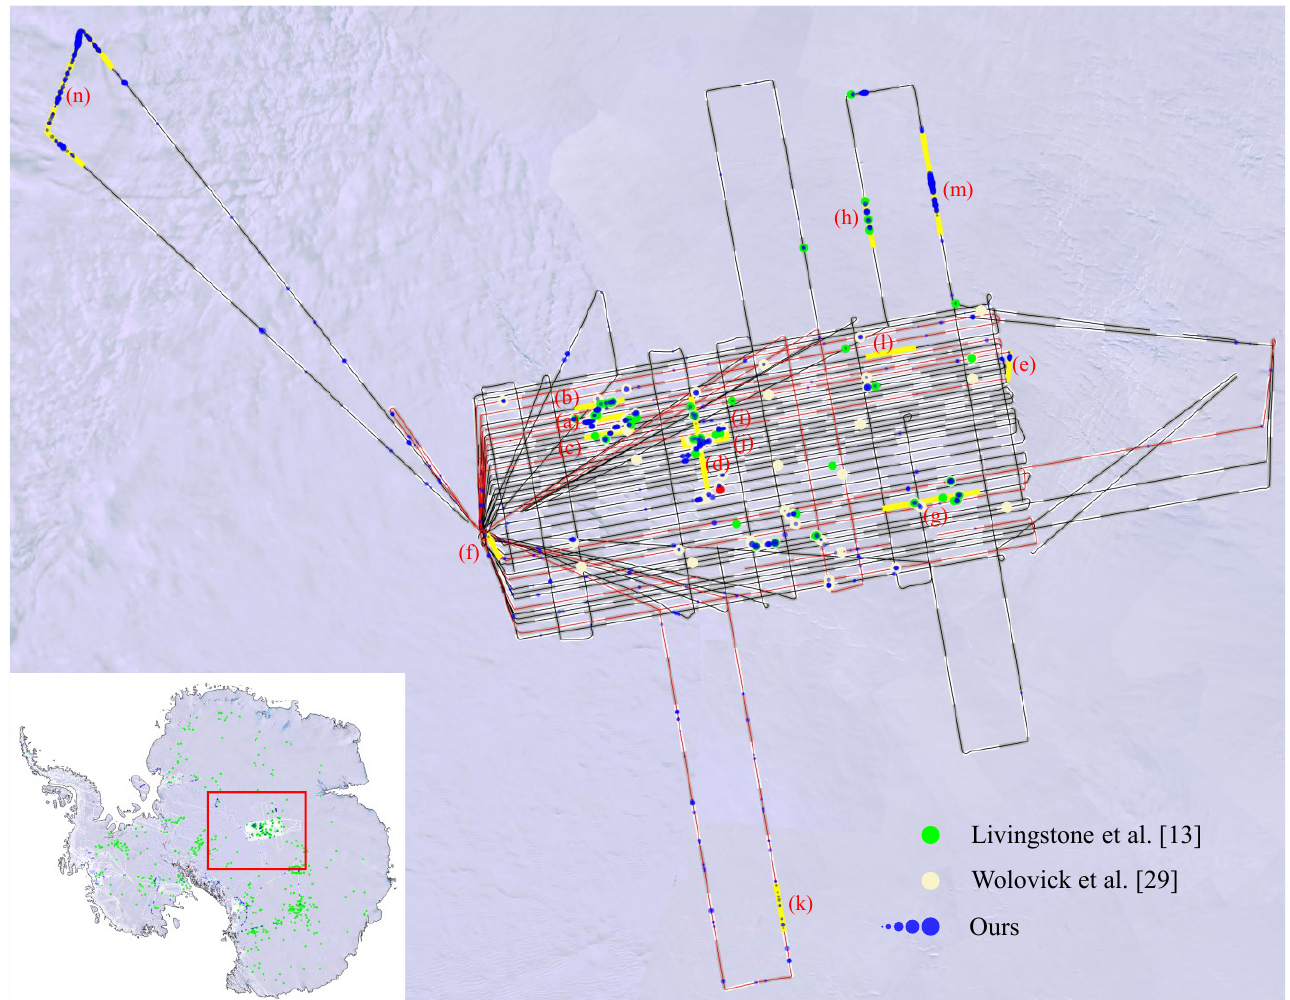
Figure 8. The distribution of subglacial water bodies in the AGAP region. Green dots represent the inventoried subglacial lakes by Livingstone et al. [13]; yellow dots represent the inventoried subglacial water bodies by Wolovick et al. [29]; blue dots represent subglacial lakes calculated by our method, and the size of the dots represents the probability of a subglacial water body.